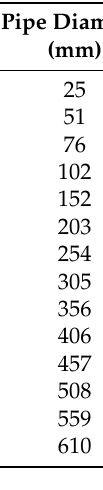
Figure 3. Layout of a two-loop network (the chord tree pipes are highlighted in red). Table 1. Commercially available pipe diameters and unit cost for both case studies.